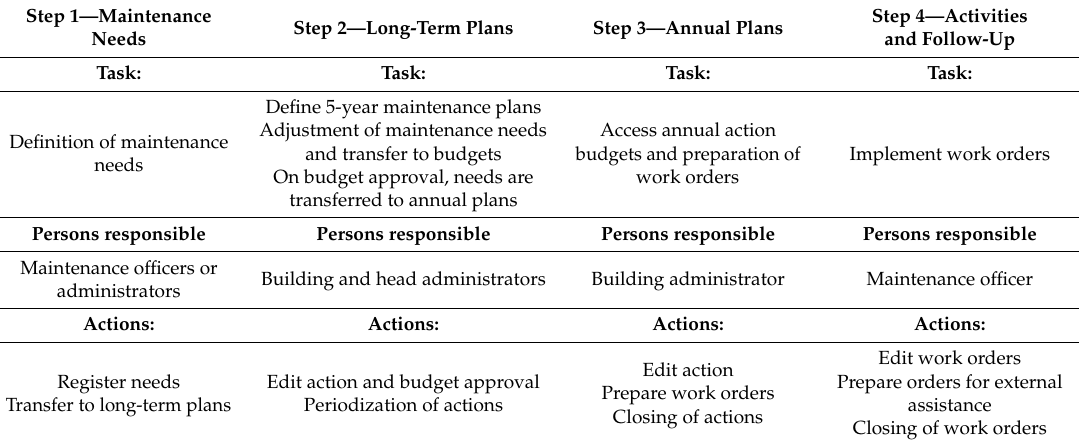
Table 6. Stepwise procedure for the management of MOM needs and tasks as exercised by the large Norwegian actor in this case